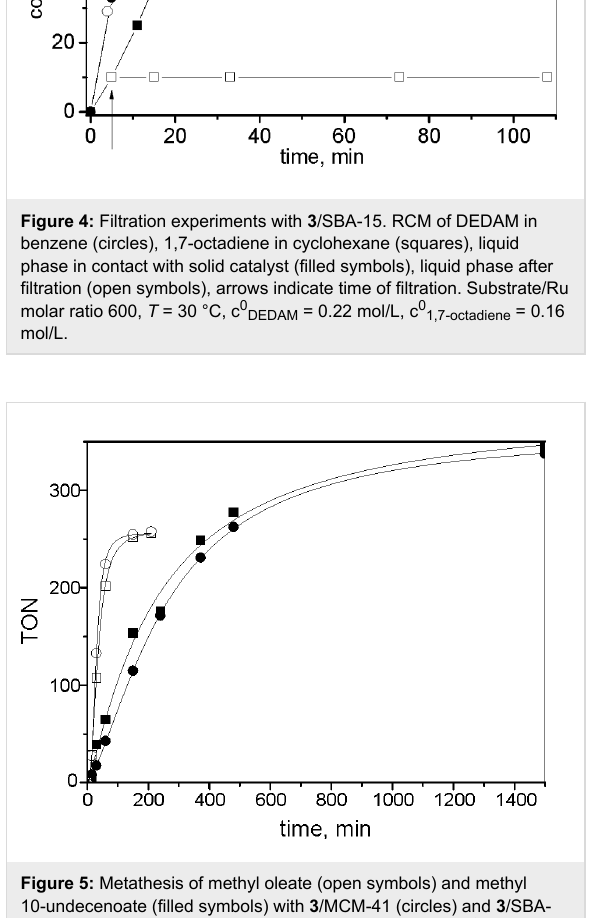
Figure 6: UV–vis spectra of 3 /SBA-15 (curve 2) and of 3 (curve 1) in dichloromethane (c = 0.001 mol/L, l = 0.2